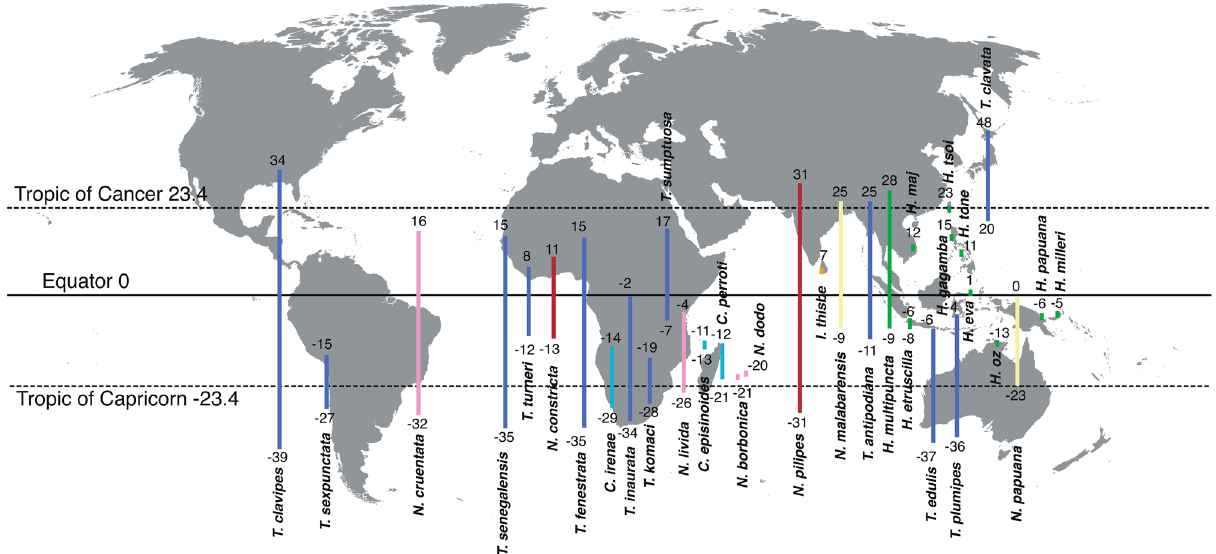
Figure 1. Approximate latitudinal ranges of 34 species of nephilid spiders included in the phylogeny. Latitudinal bars are colour-coded by genus: light blue – Clitaetra , dark blue— Trichonephila , red— Nephila , yellow— Nephilengys , orange— Indoetra , pink— Nephilingis , green— Herennia . Numbers denote latitudinal degrees of each species’ approximate range limits. The figure combines own distributional data with IUCN Red List data (https:// www. iucnr edlist.